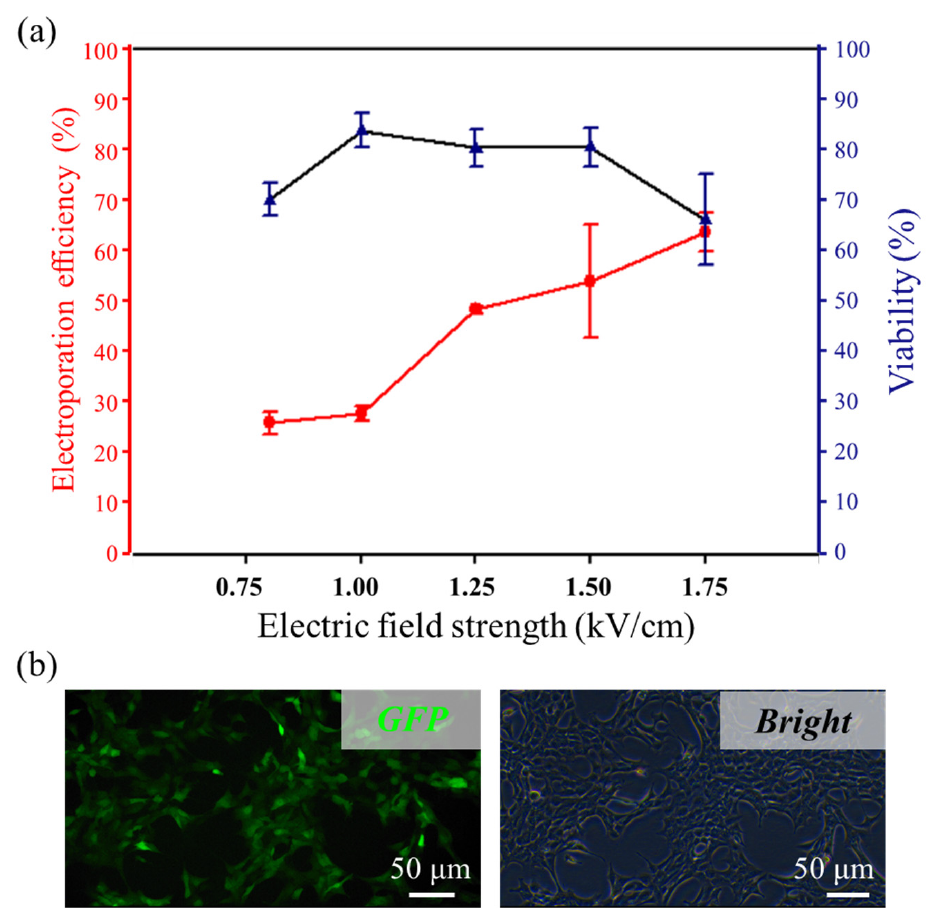
Figure 4. Transfection of plasmid in 1601 cells. ( a ) The electroporation efficiency and viability under different electric field strengths (n = 3 for every trial). ( b ) Fluorescence image of plasmid expression in the cells 24 h post-electroporation.